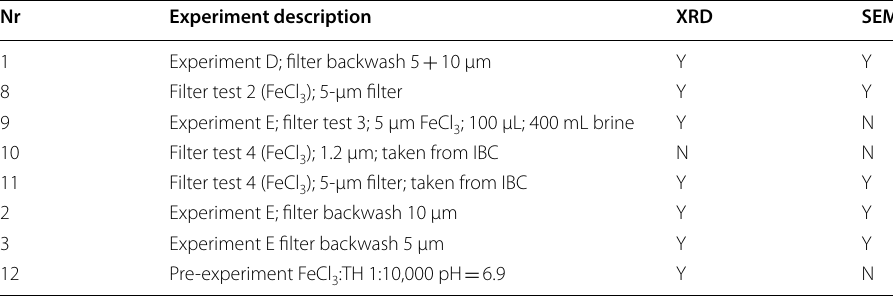
Table 2 Selected samples for solid phase analysis (XRD and SEM)